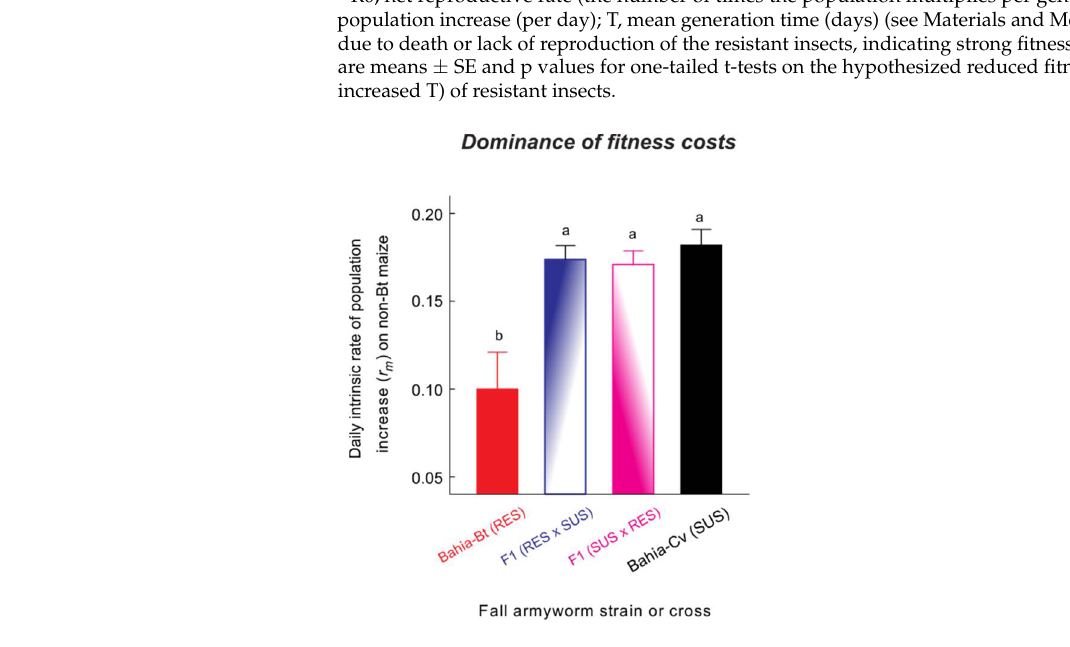
Figure 4. Dominance of the fitness costs associated with resistance to dual-gene Bt maize (Cry1A.105+Cry2Ab2) in the invasive fall armyworm ( Spodoptera frugiperda ) . Shown are intrinsic rates of population increase ( r m ) for the susceptible and resistant populations and for the offspring of their reciprocal crosses, all of them reared on leaves of non-Bt maize. Means ± standard errors followed by the same letter are not significantly different ( p > 0.05, t -test using the jackknife estimate of variance with α correction using Bonferonni procedure).